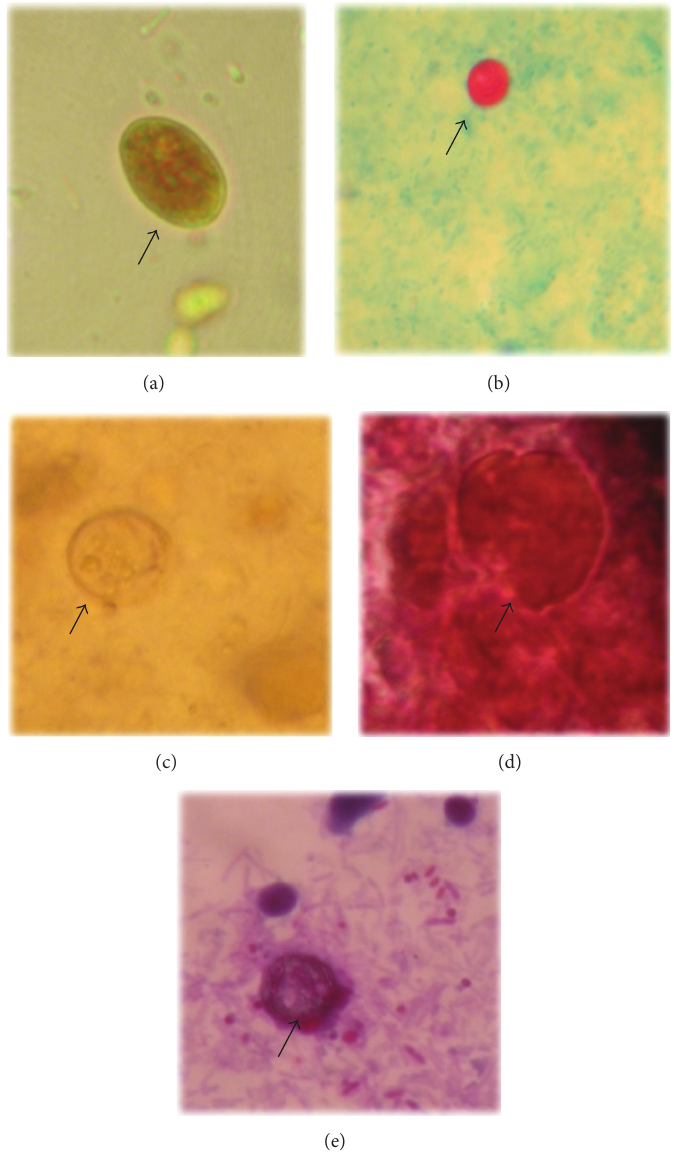
Figure 2: Merged microscopic pictures for wet mounts smears of formol-ether fecal concentrates showing the recognized enteric protozoa. (a) Giardia duodenalis cyst (iodine stain, 400x magnification), (b) Cryptosporidium spp. oocyst (modified Ziehl-Neelsen stain, 400x magnification), (c) Entamoeba histolytica/Entamoeba dispar cyst (iodine stain, 400x magnification), (d) Blastocystis spp. vacular form (trichrome stain, 1000x magnification), and (e) Cyclospora spp. oocyst (mZN stain, 400x